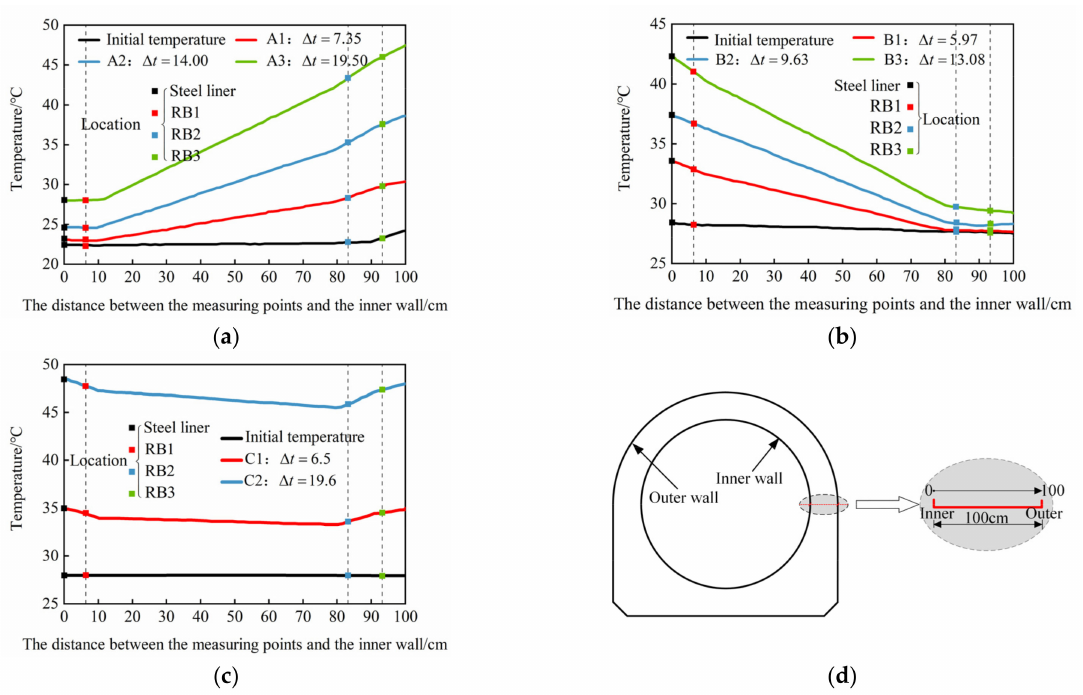
Figure 8. Temperature fields of the test model: ( a ) the inner wall temperature is lower than the outer; ( b ) the inner wall is higher than the outer; ( c ) the inner wall temperature is the same as the outer; ( d ) measuring points